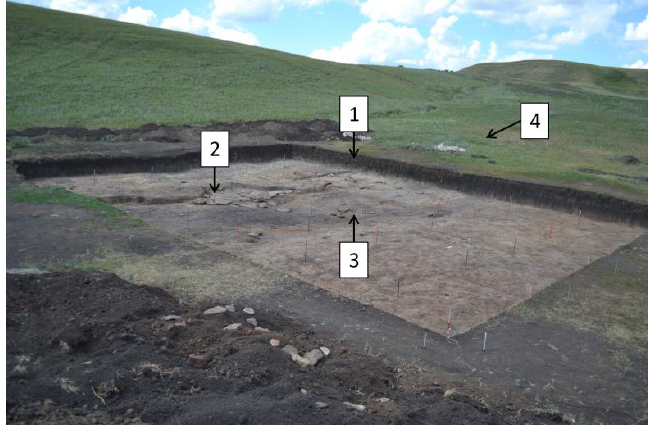
Figure 3. General view of the Tyater-Araslanovo-II settlement archeological site and location of the studied soil pits.